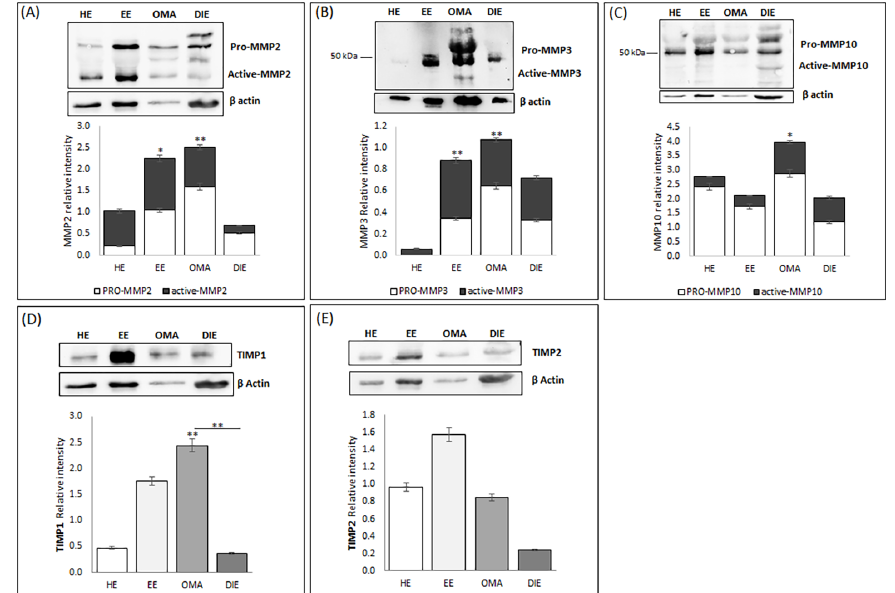
Figure 2. Expression of MMPs and TIMPs in human healthy (HE) and eutopic (EE) endometrium, in endometrioma (OMA) and in deep infiltrating endometriosis lesions (DIE). ( A – C ) Western blot of MMP2, MMP3, MMP10; β Actin was immunodetected to control for loading per lane. The relative migrations of pro- and fully mature MMPs are indicated. Computer-assisted semiquantitative analysis of the overall relative intensity of the bands, measured (pixel/mm 2 ) and then normalized relative to ACTB. Relative intensities are plotted ratio of active versus pro-form. ( D , E ) Western blot of TIMP1 and TIMP2; β Actin was immunodetected to control for loading per lane. The intensity was measured (pixel/mm 2 ) and then normalized relative to β Actin. The experiments, independently repeated twice on a pool of 5 patients for each group, gave similar results. * p < 0.05; ** p < 0.01.